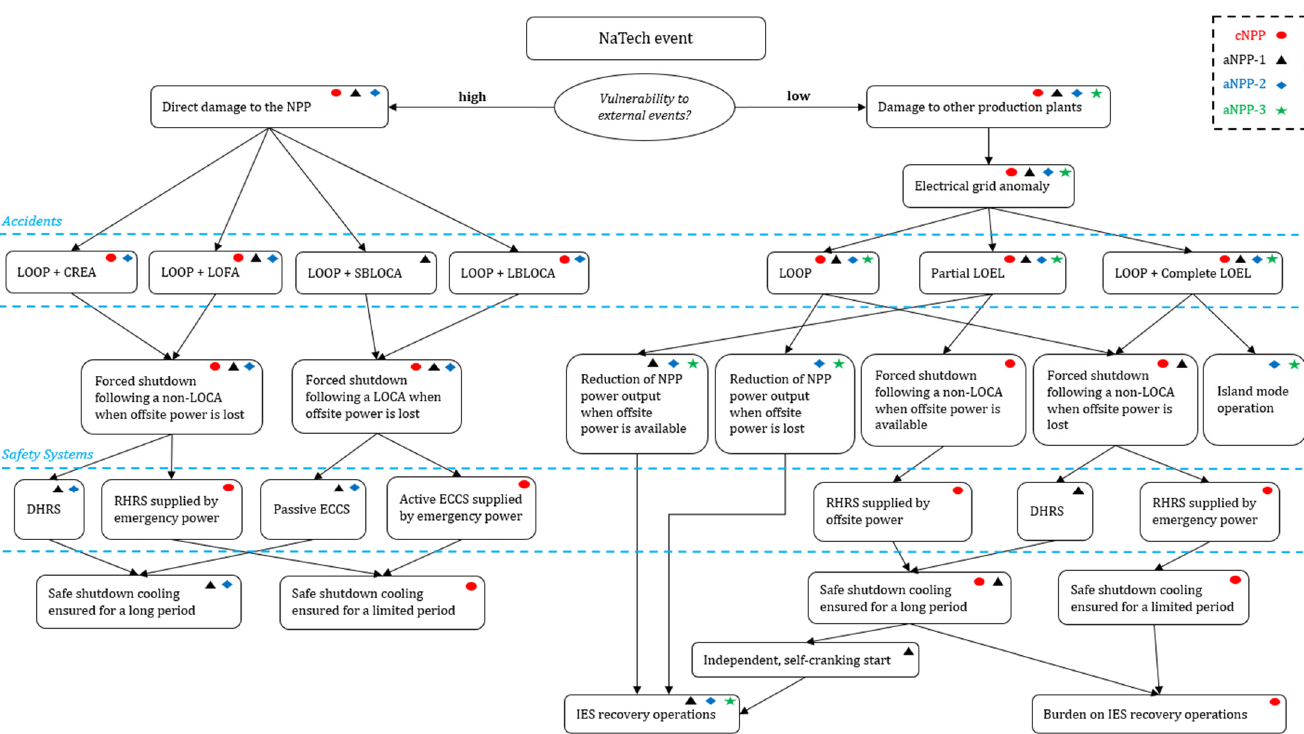
Figure 2. Sketch of the similarities and differences between the evolution of scenarios following the occurrence of an IES ‐ wide NaTech event, for the cNPP and the aNPPs.